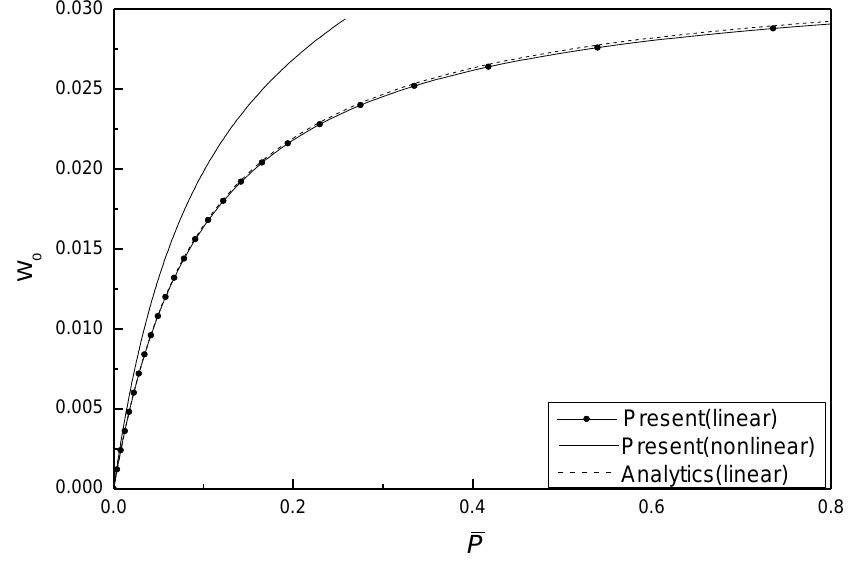
Figure 4. Response curves of the centre deflection vs. compressive loads in plane without